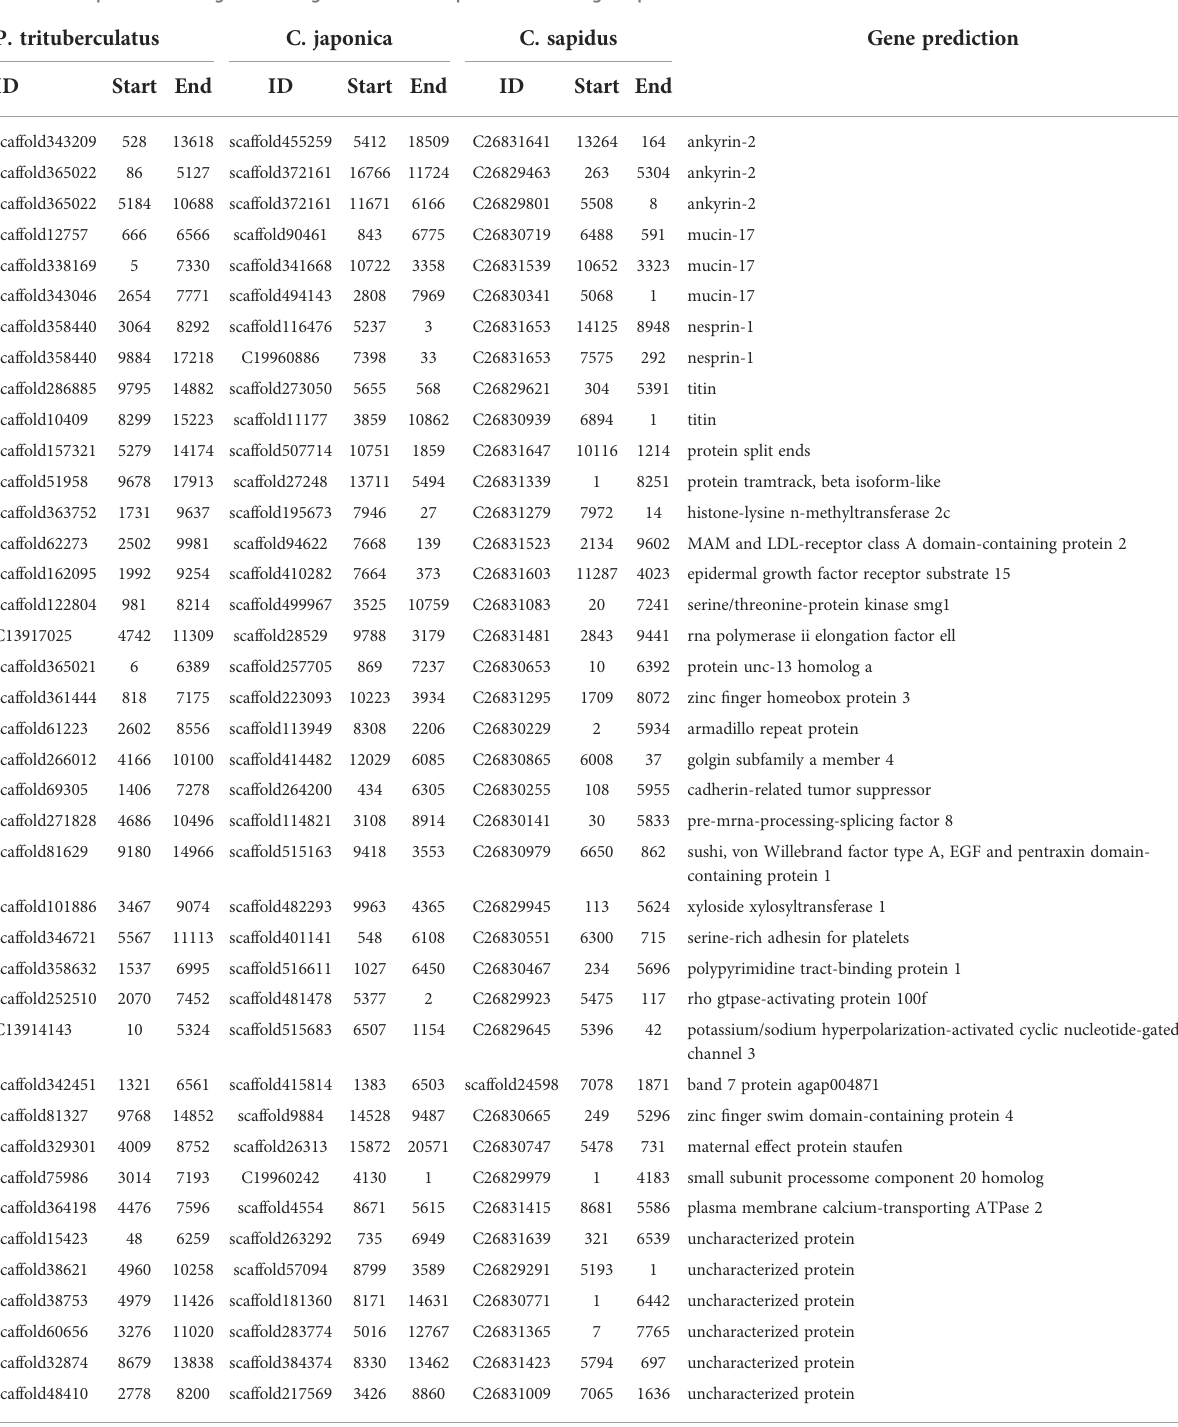
TABLE 5 Top 40 similar regions among the three crab species and their gene prediction